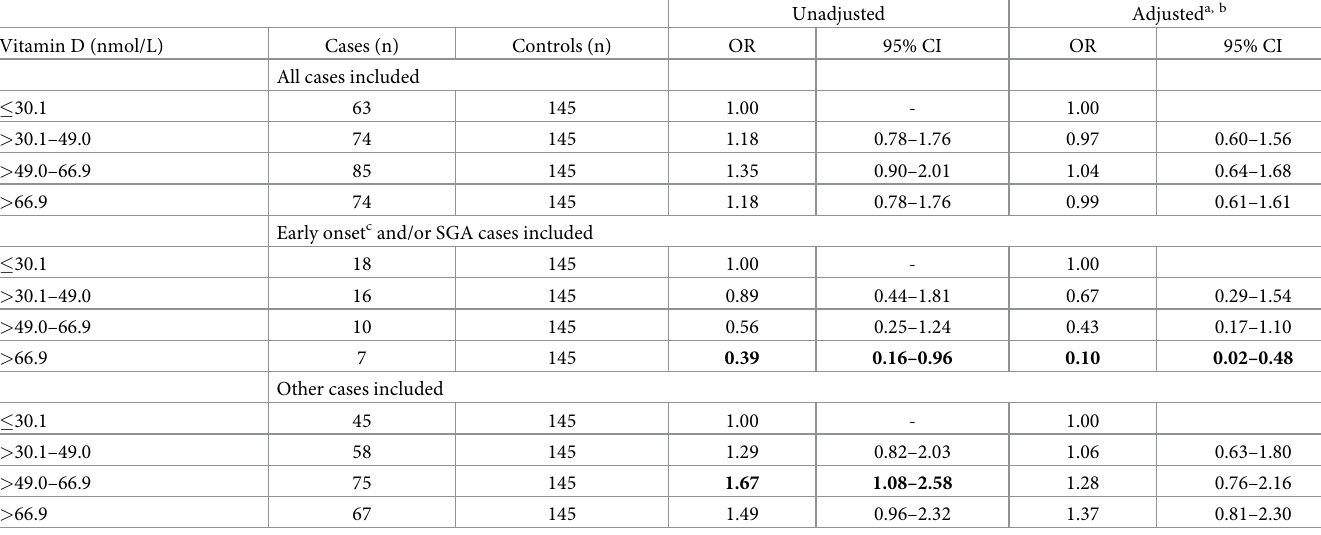
Table 3. The associations between concentrations of vitamin D (25-hydroxyvitamin D3) in maternal serum in early pregnancy and preeclampsia. The cut-offs were based on quartiles among the controls. Odds ratios (OR) and 95% confidence intervals (CI) were obtained from logistic regressions.